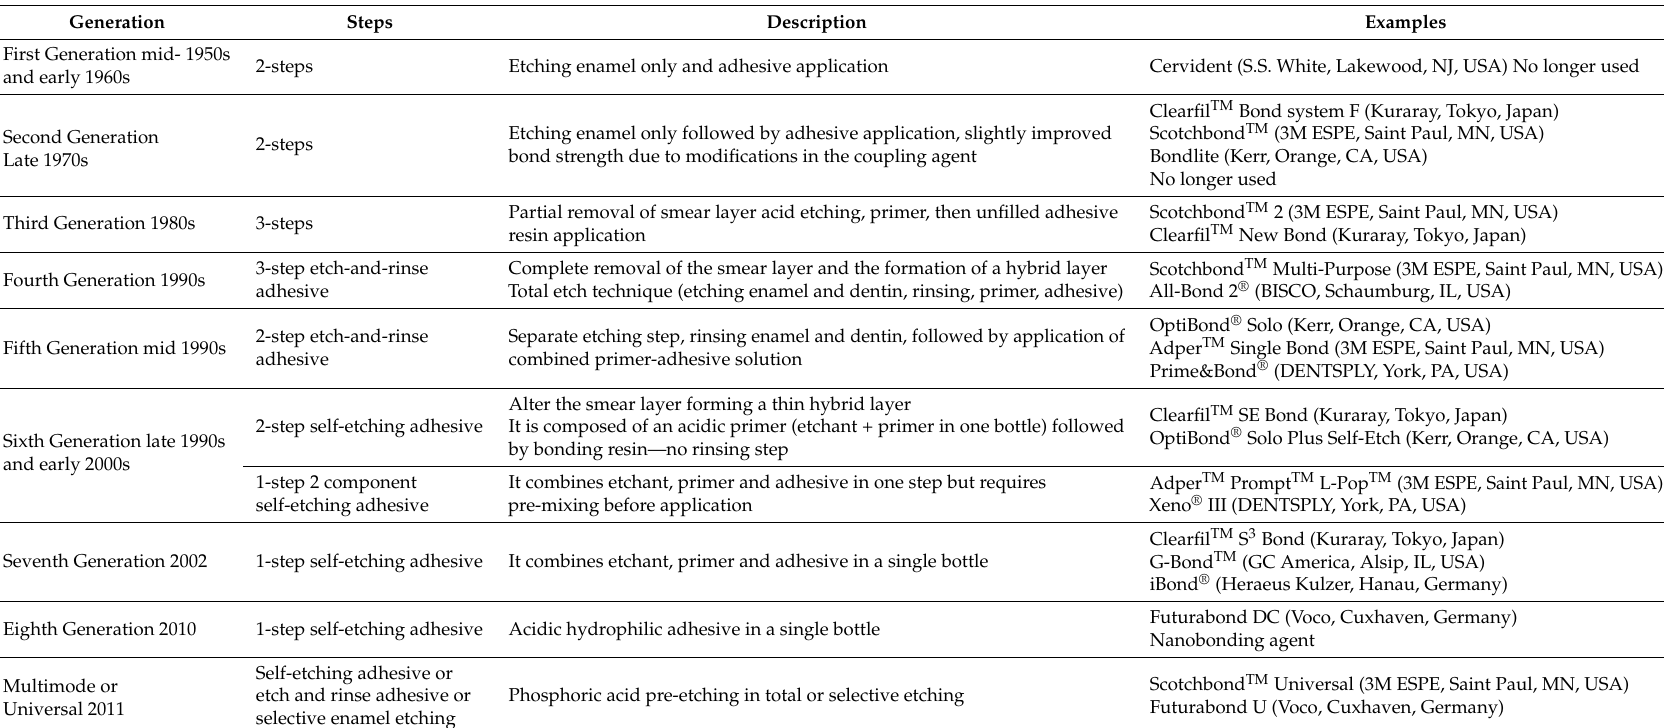
Table 3. Historical development of dentin bonding